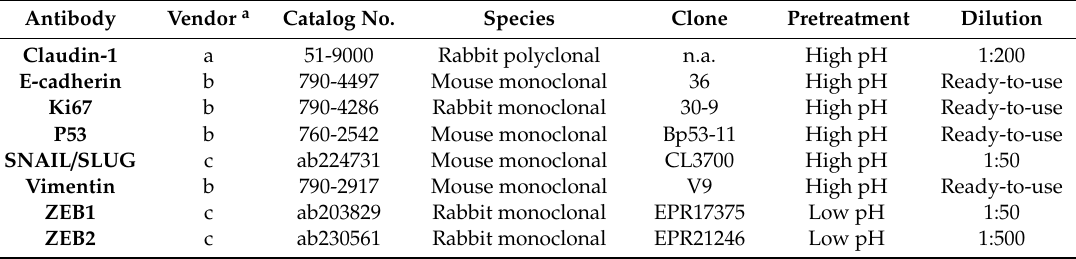
Table 1. Immunohistochemistry (IHC)